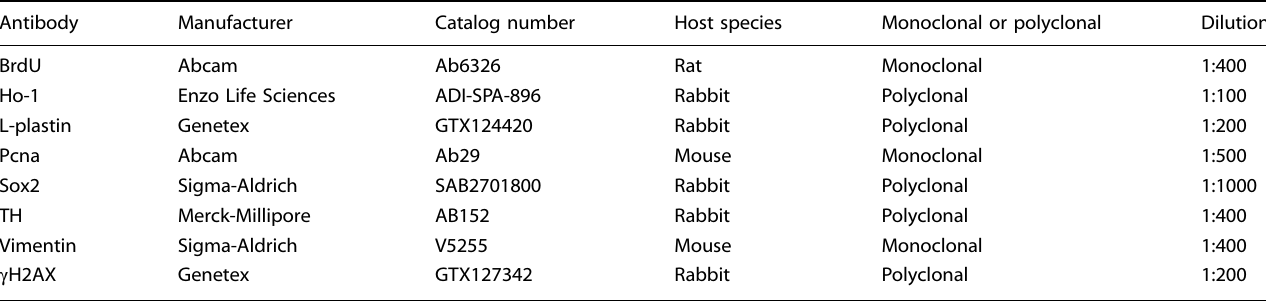
Table 2. List of the primary antibodies used for